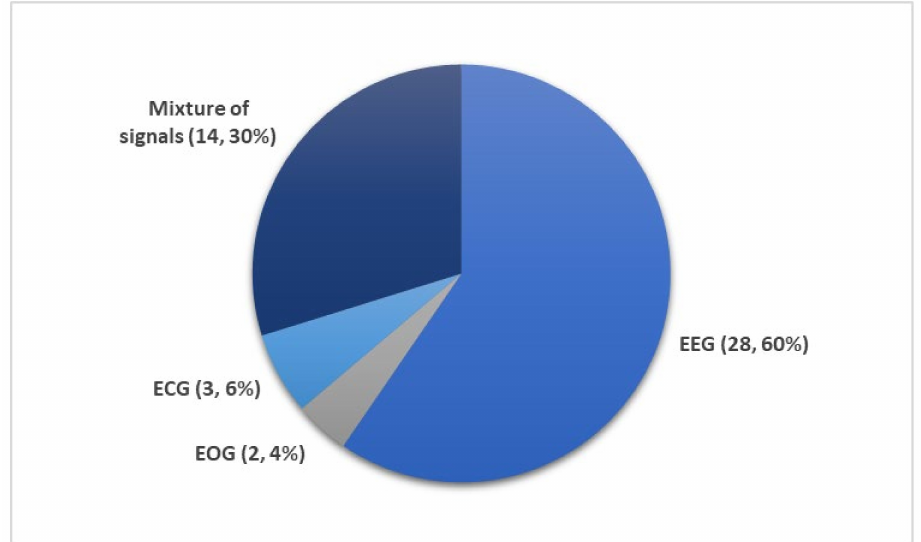
Figure 8. Di ff erent subsets of PSG recordings used to train DL models for automated sleep stage classification as listed in Tables 1–5. Of the 36 studies, the mixture of signals (electrooculogram (EOG), electromyogram (EMG), and electroencephalography (EEG)) was employed 14 times while EEG signals were used 28 times. Only a small fraction (five studies) employed ECG or EOG time series. * Summary statistics: using EEG versus EEG + additional